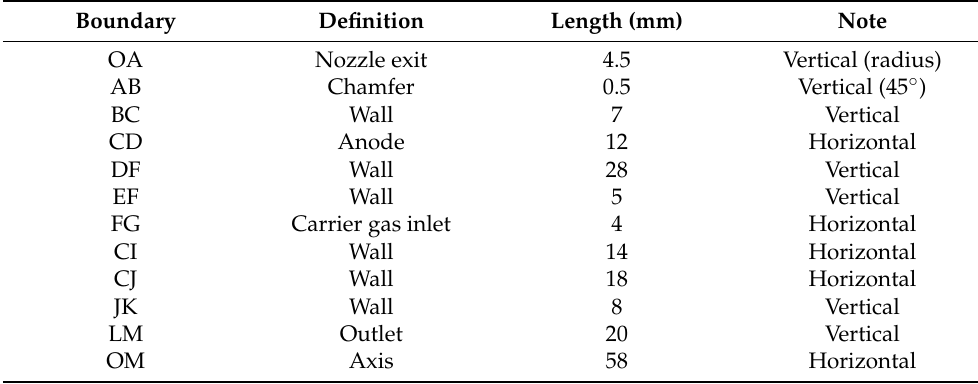
Figure 2. ( a ) General view of plasma torch and calculation domain, ( b ) 3D schematic for plasma jet simulation, and ( c ) 3D schematic for plasma jet simulation (cross-sectional view). Table 3. Main characteristic length for plasma jet simulation domain.